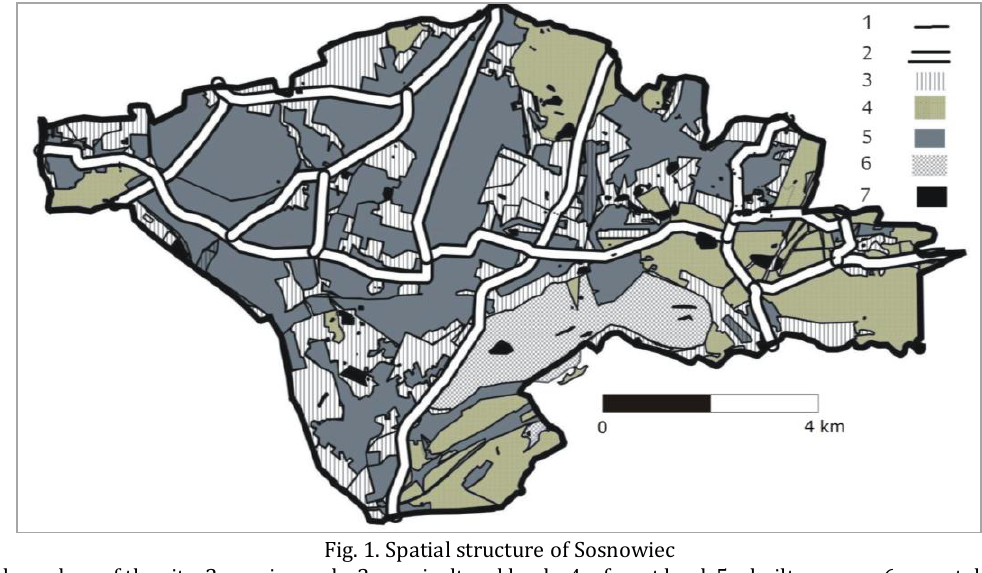
Fig. 1. Spatial structure of Sosnowiec